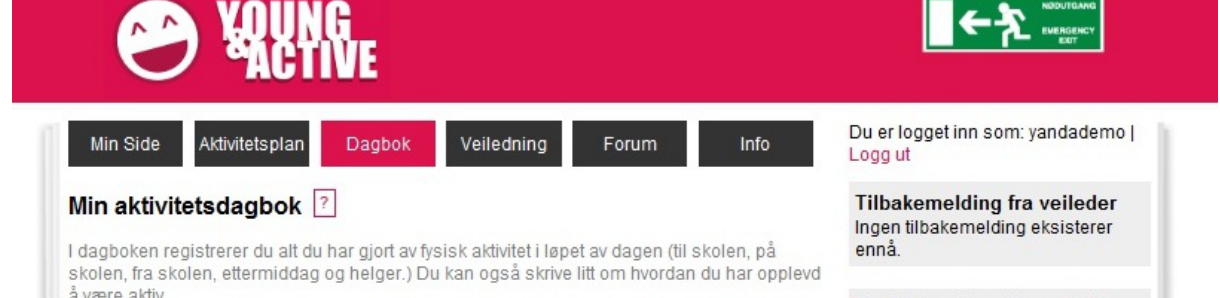
Figure 3. A screenshot of the page for daily registration and diary notes on physical activity. The right panel has links to the last feedback from counselor, short messages to and from counsellor, the last comment on the forum, and a graphic presentation of the planned and registered activity for the present